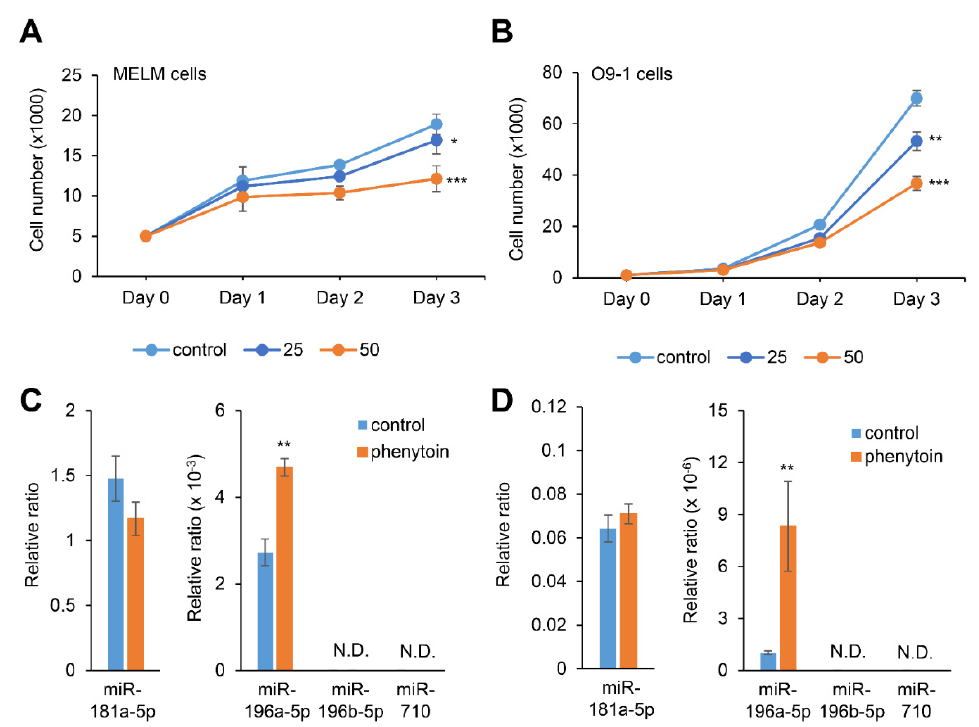
Figure 3. Influence of phenytoin on cell proliferation and microRNA (miRNA) expression in mouse embryonic lip mesen- chymal (MELM) and O9-1 cells. ( A , B ) Cell proliferation assays with MELM cells ( A ) and O9-1 cells ( B ) treated with 25 or 50 μ g/mL phenytoin for 24, 48, and 72 h. * p < 0.05, *** p < 0.001 versus control ( n = 6). ( C , D ) Quantitative RT-PCR for miR- 181a-5p, miR-196a-5p, miR-196b-5p, or miR-710 after treatment of MELM cells ( C ) and O9-1 cells ( D ) with phenytoin for 72 h. ** p < 0.01 ( n = 6). N.D., not detected.